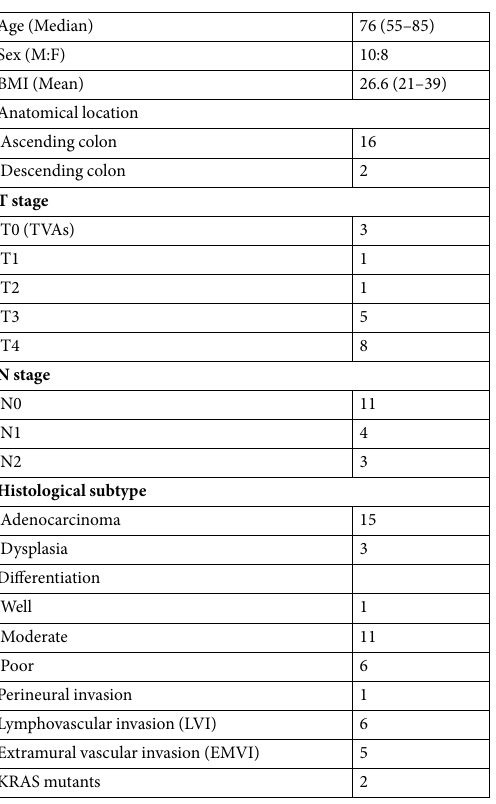
Table 1. Patient demographic and pathological data. BMI: Body Mass Index; TVA: Tubulovillous adenoma; KRAS: Kirsten rat sarcoma viral oncogene